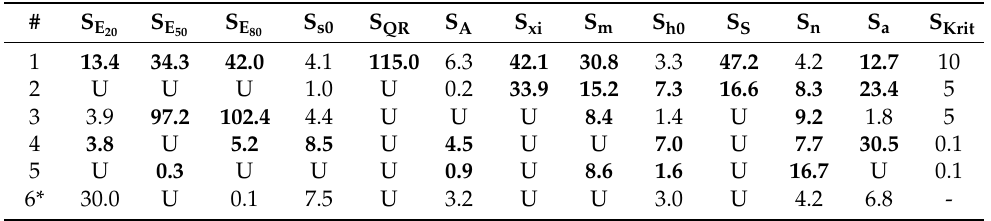
Table 5. Sensitivity values during identification. Parameters that fulfil the criterion are shown in bold.